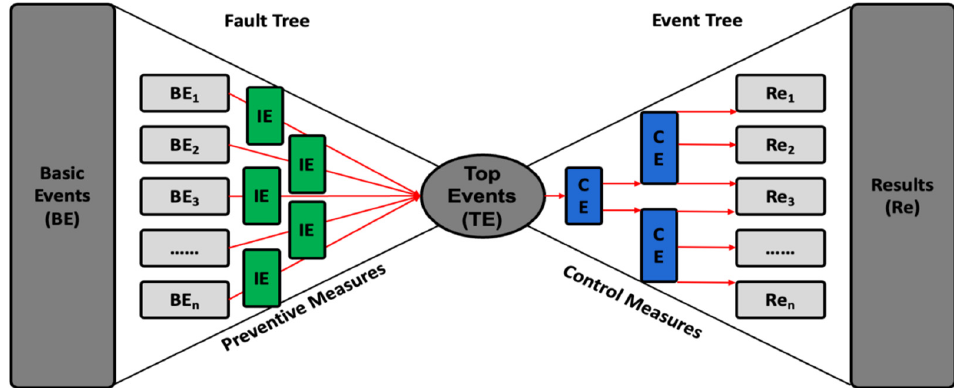
Figure 6. Bow-tie model-based risk control of unsafe events during FPE.